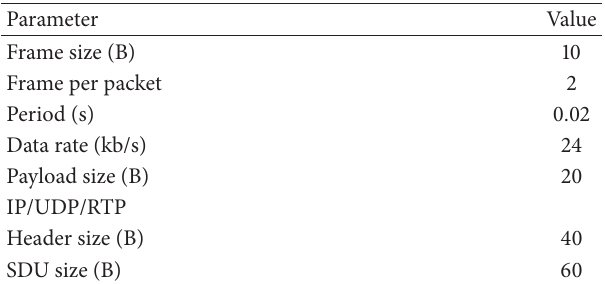
Table 2: G.729A VoIP traffic stream parameters.